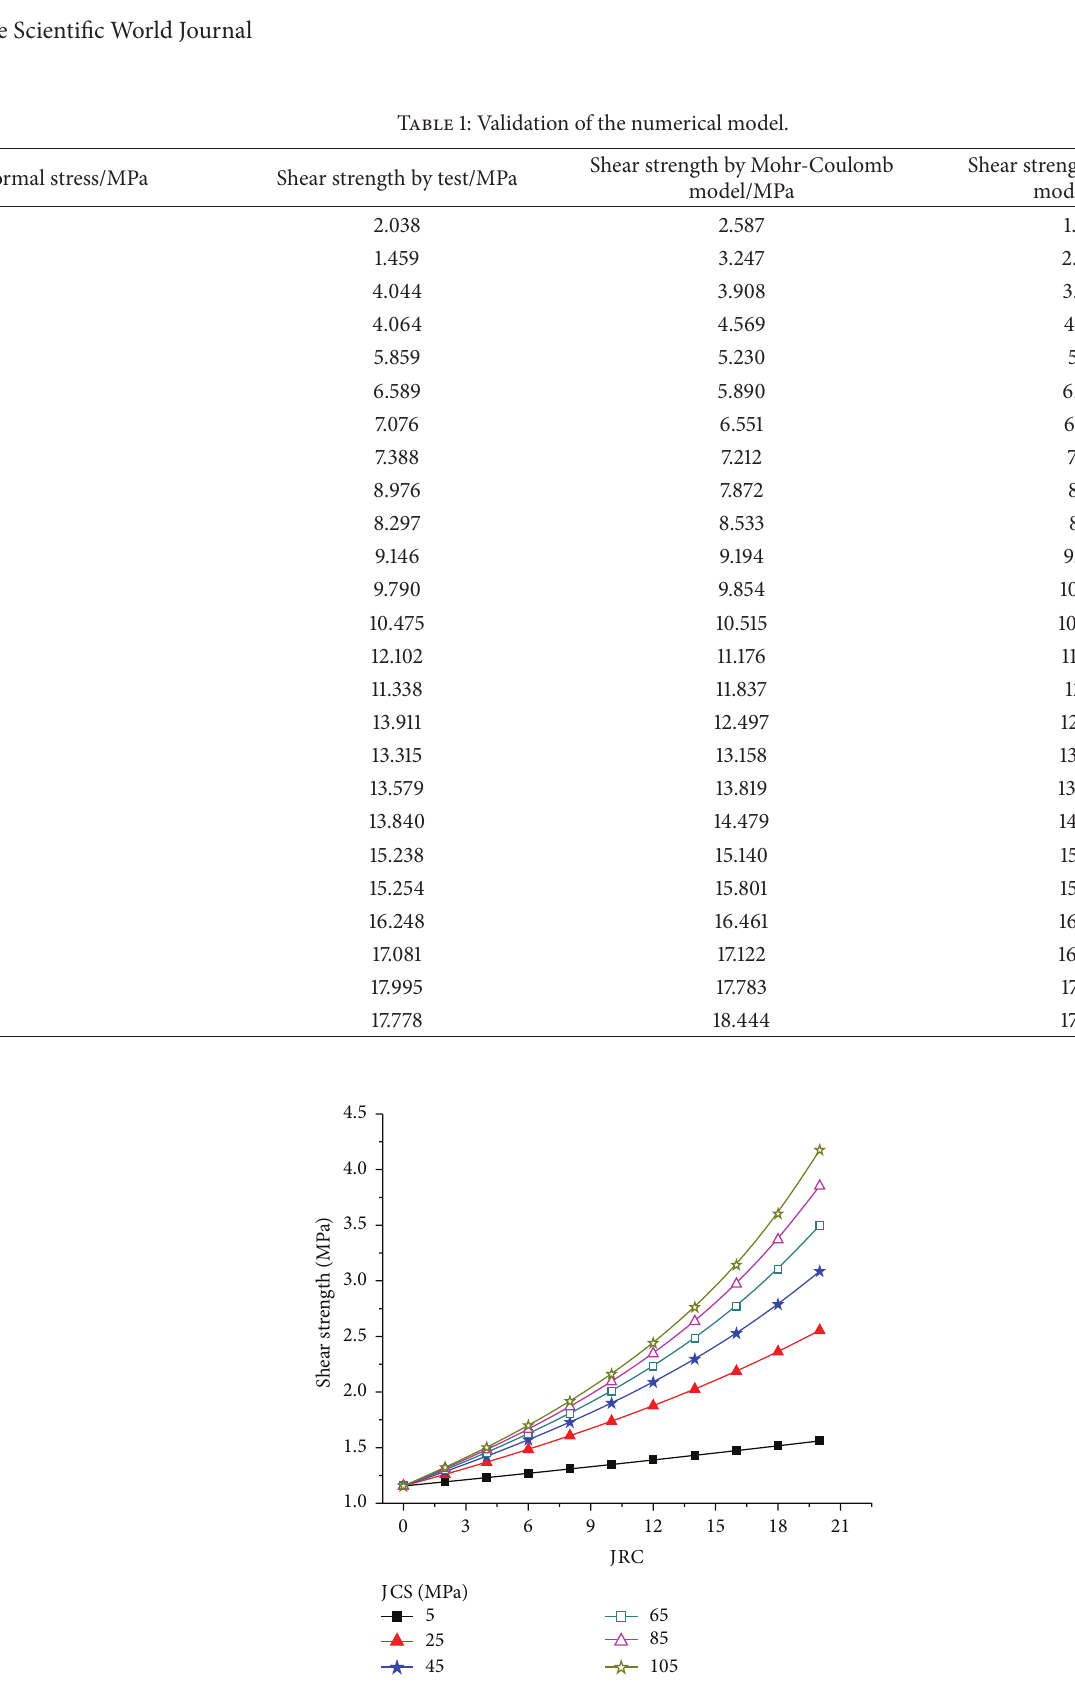
Figure 5: Relationship between the JRC and shear strength of the joint